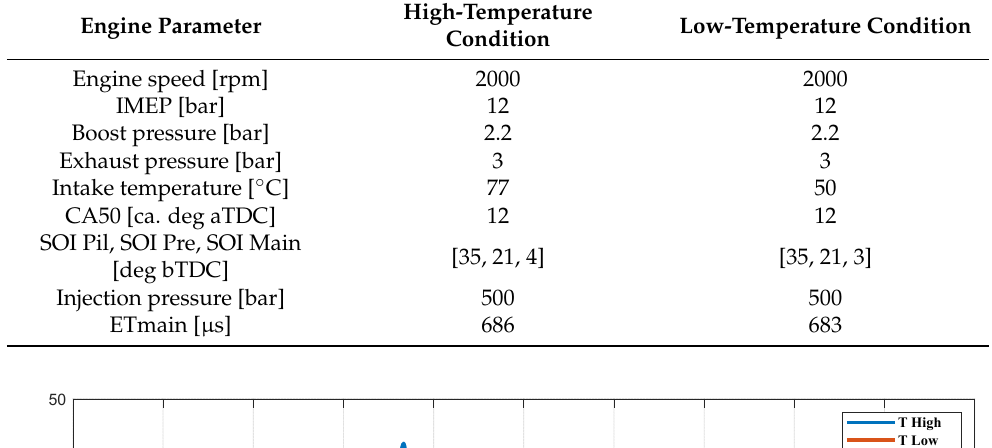
Table 2. Engine operating conditions testing the effect of two different levels of intake temperature on ID.